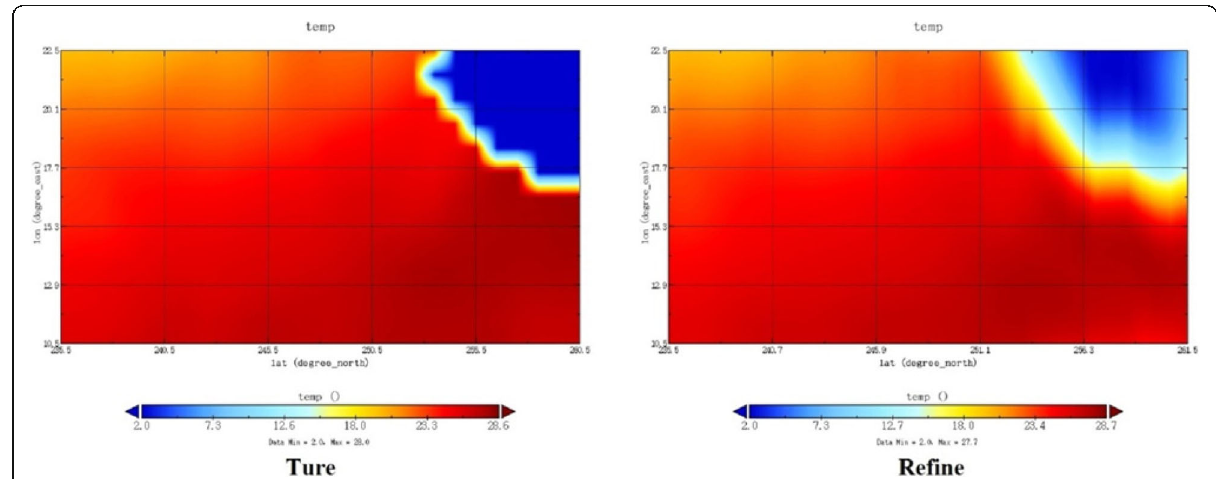
Fig. 4 The comparison of the temperature distribution in the study area under the real data and high-resolution